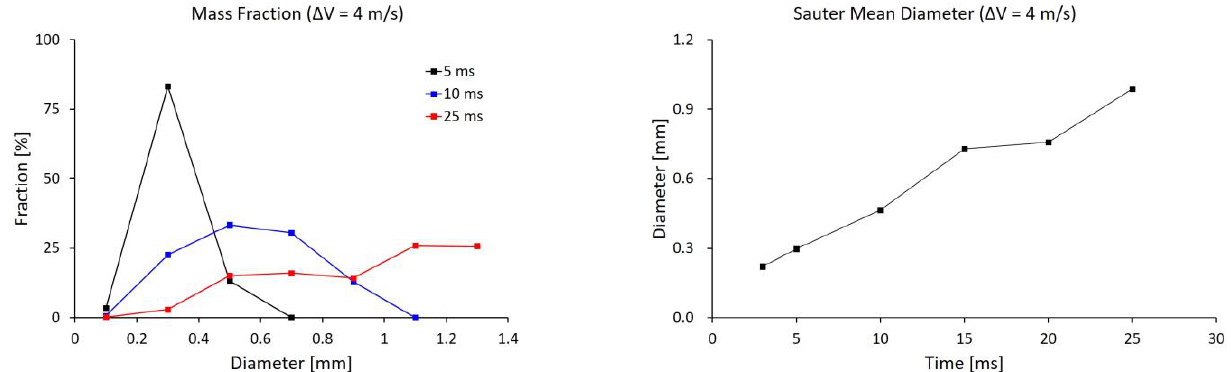
Figure 11. Time variation of particle size distribution in jet breakup by Kelvin–Helmholtz instability.